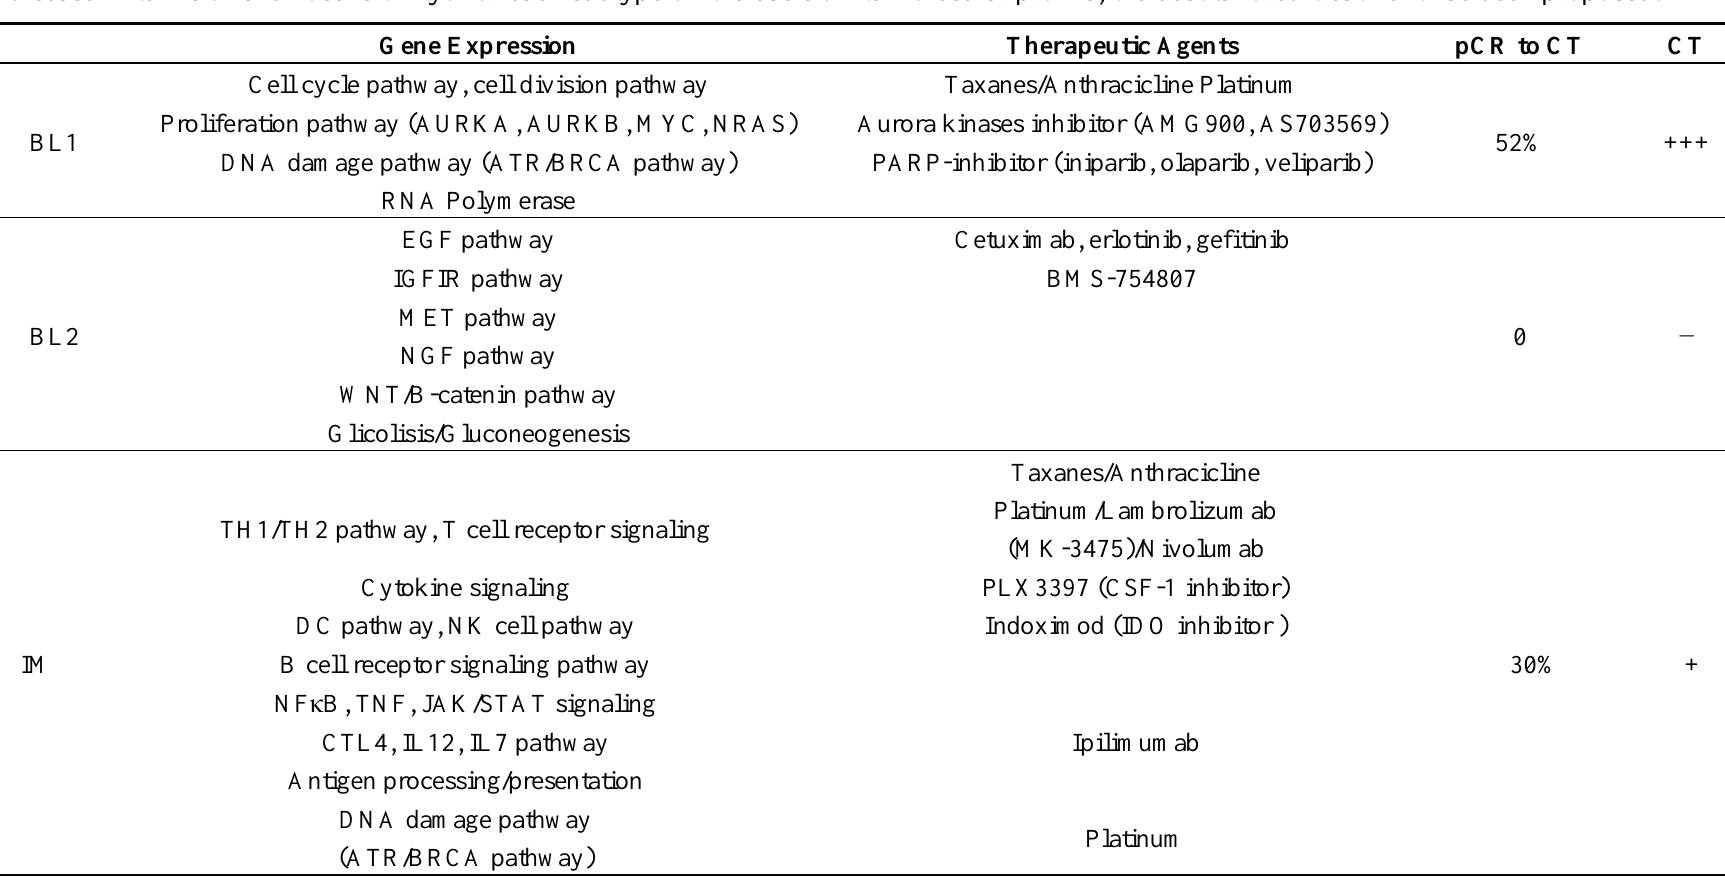
Table 1. Clinical relevance of the heterogeneity in TNBC. The classification into subtypes can differentiate diseases by their gene expression profiles and relative chemosensitivity, encouraging innovative approaches to personalized therapies. The gene expression profiling of primary TNBC allows to stratify them in different subtypes. The stratification into subtypes has clinical value and is able to differentiate each primary disease in terms of chemosensitivity. For each subtype on the basis of its molecular profile, the best tailored treatment has been